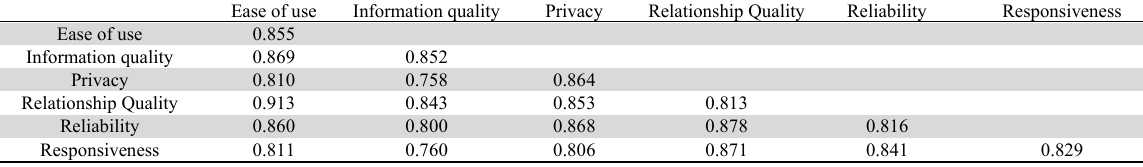
Results summary for Discriminant Validity (Fornell –Larcker